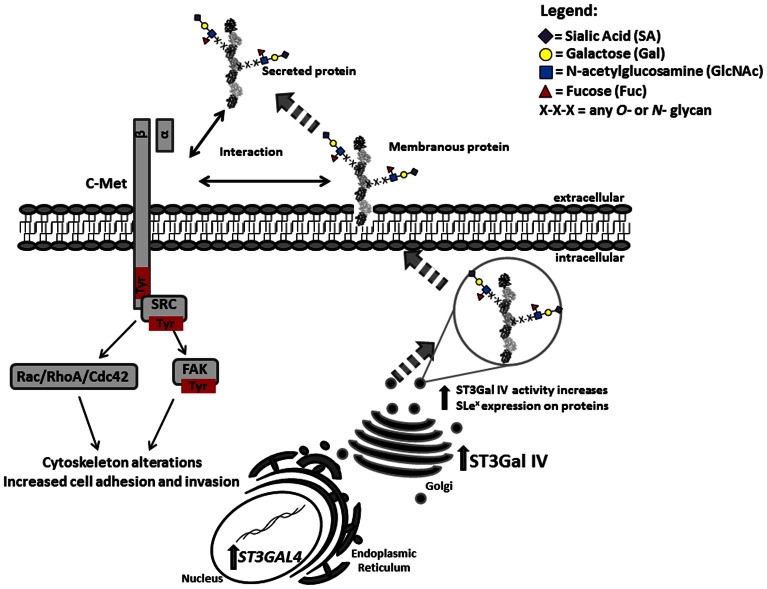
Schematic representation of the alterations induced by increased expression of SLex and activation of c-Met.Increased transcription of ST3GAL 4 leads to increased expression of the ST3Gal IV enzyme in the Golgi apparatus of the cells. This enzyme will glycosylate type-2 terminal oligosaccharide chains leading to the presence of SLex in glycoproteins targeted for the membrane or to be secreted by the cells. The expression of SLex in membrane-associated and secreted proteins can promote the interactions between these proteins and c-Met leading to its activation. c-Met activation leads to downstream signaling activation target proteins Src, FAK and Rho GTPAses leading to a modified cell-matrix adhesion and an increased cell invasion.